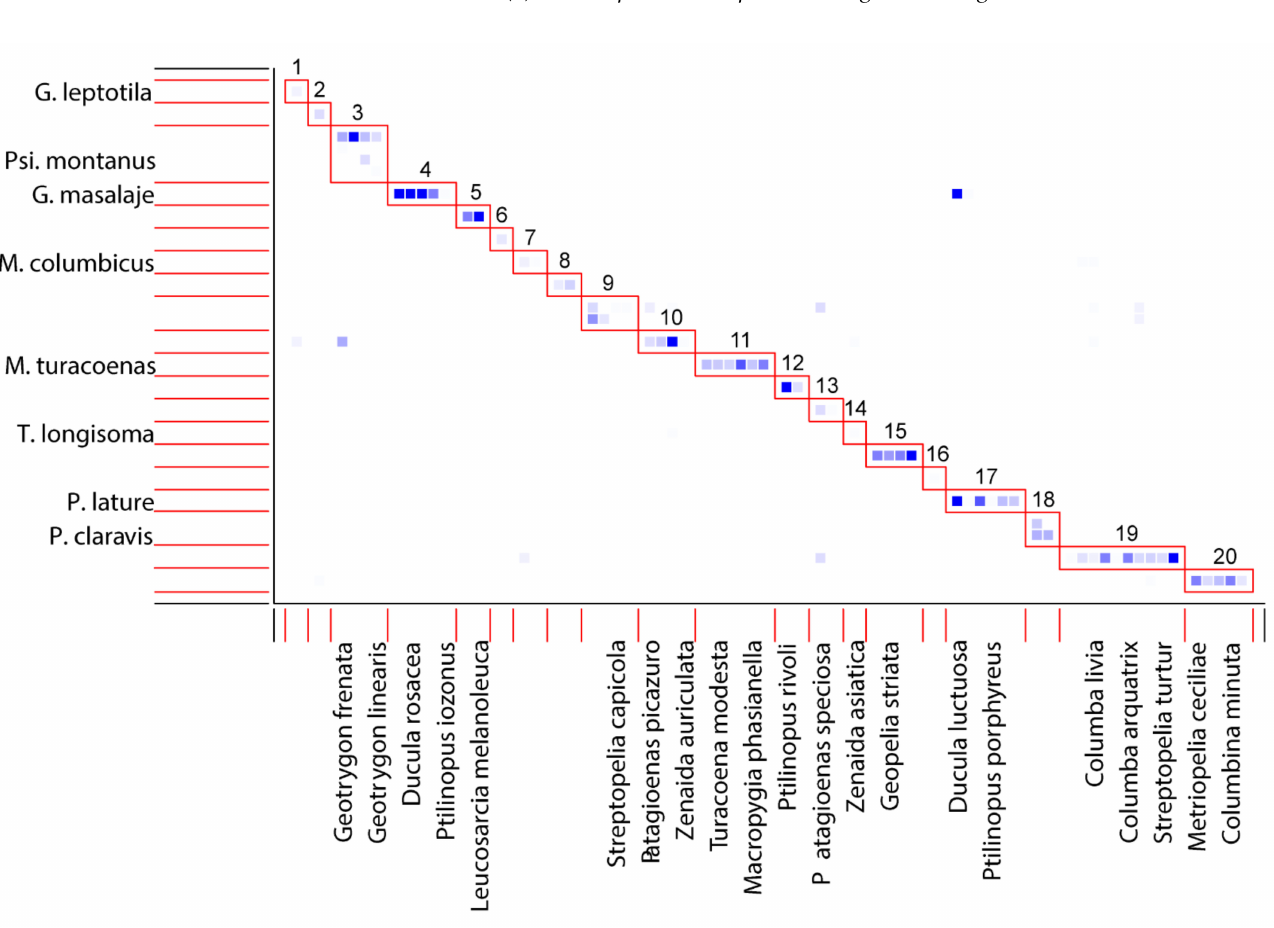
Figure 2. Modules of the quill mites–doves communities. Modules 1–20, generated for quill mites species and doves and pigeons. The intensity of the colors of the squares indicates the strength of the interaction, between particularly parasites species (vertical axis) and their hosts species (horizontal